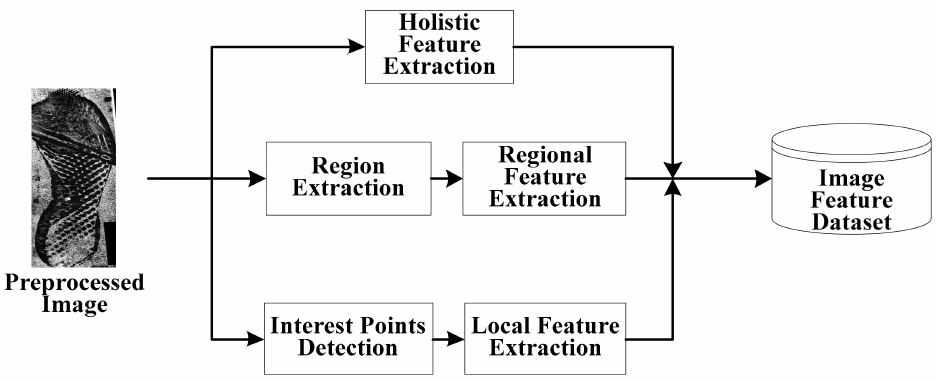
Figure 6. The framework of the feature extraction